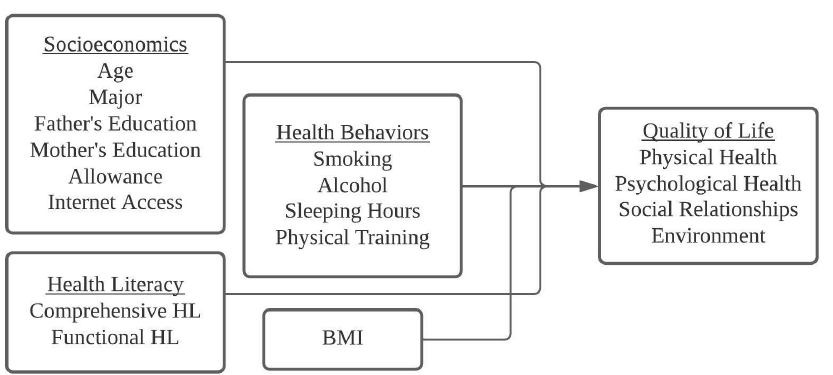
Figure 1. Hypothetical association between socioeconomic determinants, HL, HBs, BMI, and QOL.